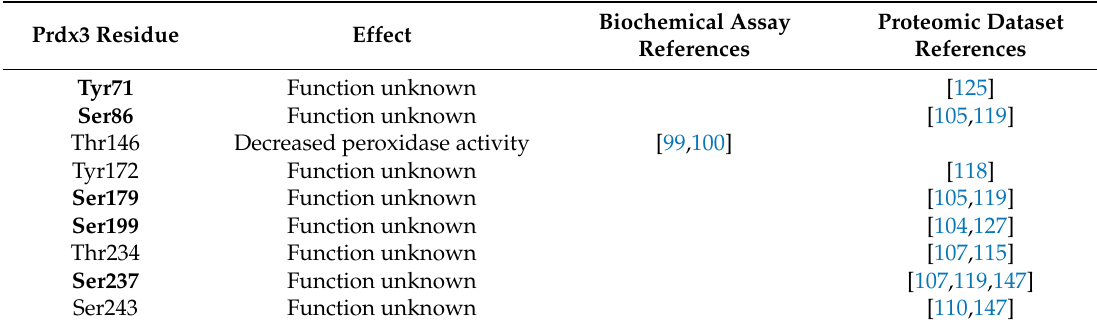
Table 3. Phosphorylation of Prdx3 can decrease peroxidase activity to coordinate cell signaling. Phosphorylation sites that correspond to human Prdx3 in biochemical assays and proteomic studies are referenced are indicated. Phosphorylation sites that have been identified in proteomic screens in cancer models are in bold.